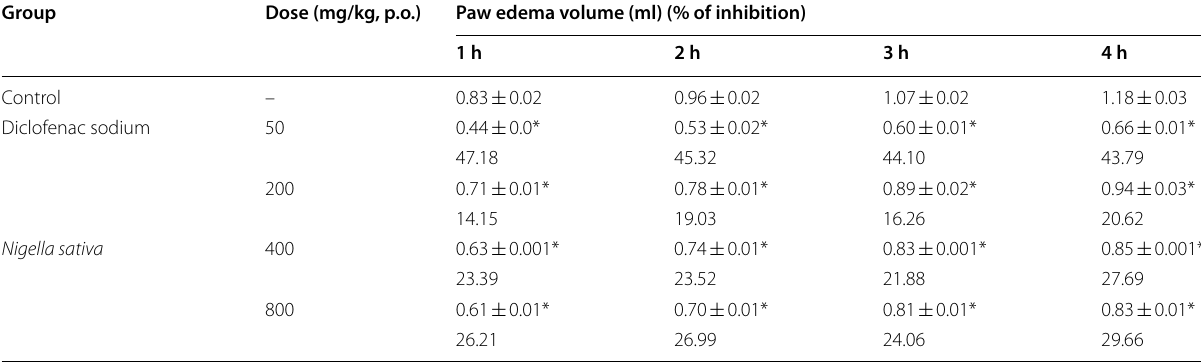
a Presented as mean * p < 0.05 compared with the control group (Dunnett’s test)